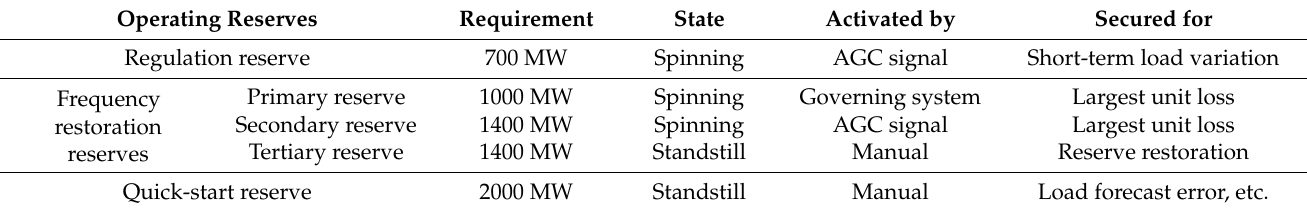
Table 2. Operating reserve requirements for the Korean power system.